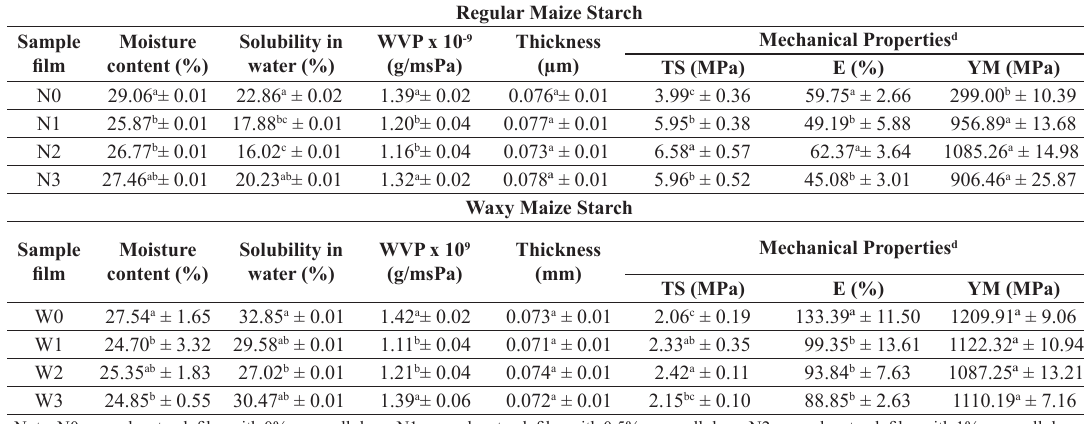
Table 1. Moisture content, solubility in water, water vapor permeability (WVP) and mechanical properties of regular and waxy maize starch films reinforced with cellulose nanofibers